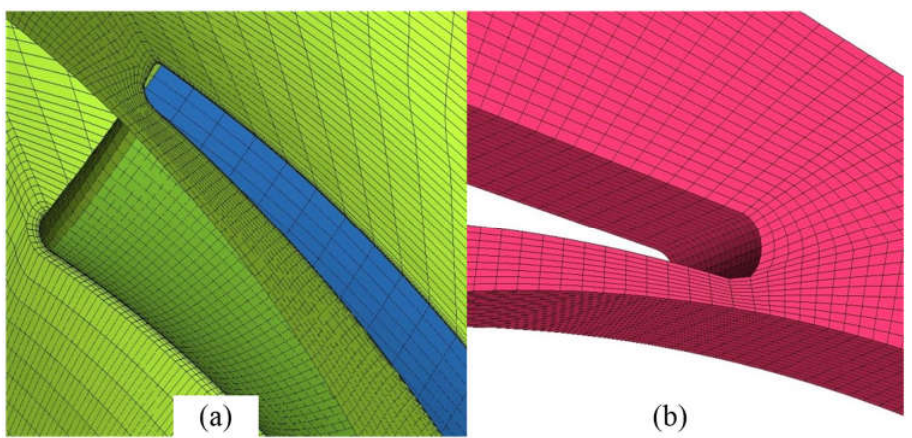
Figure 4. Analysis of independence of grids of the mesh.